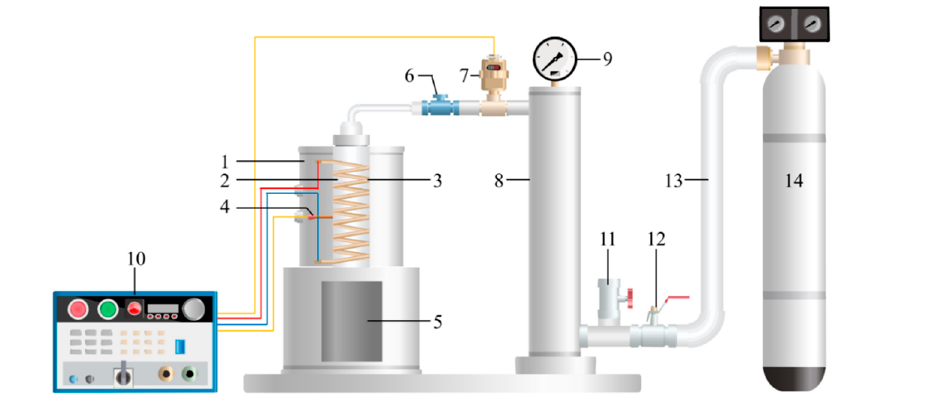
Figure 3. Godbert-Greenwald (G-G) furnace.